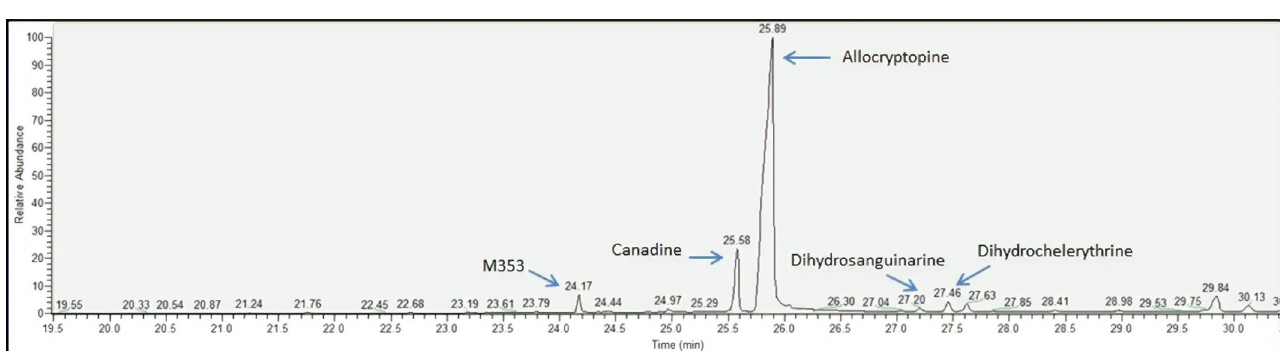
FIGURE 1 - A partial GC-MS chromatogram of Glaucium corniculatum subsp. refractum with retention times of the main